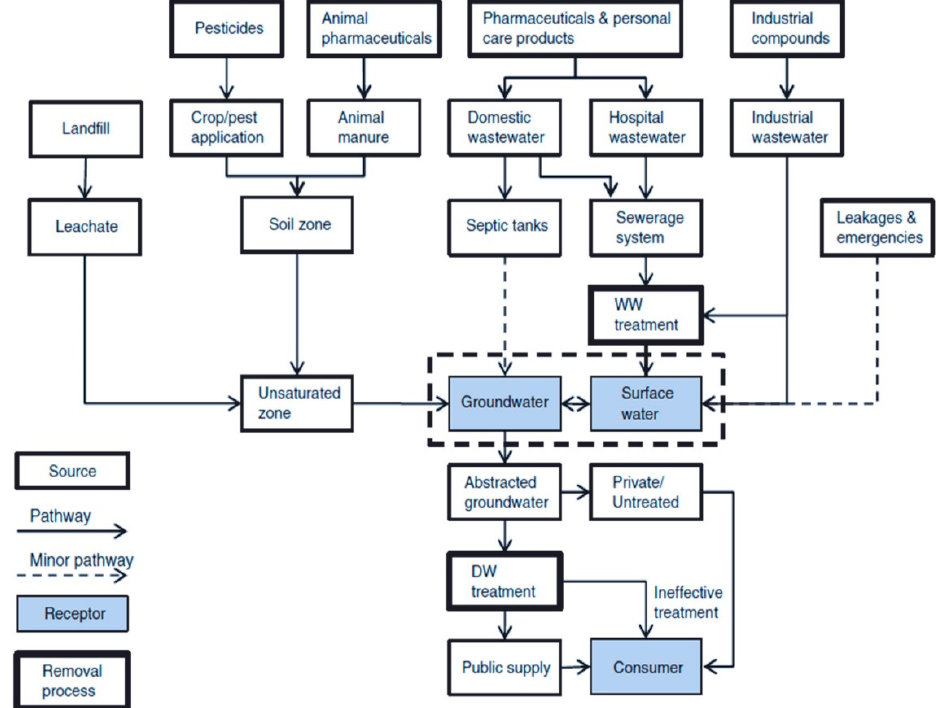
Figure 1. Scheme depicting various sources and transport of CECs from source to receptors. Reprinted with permission from [4]. Copyright 2019 American Chemical Society.